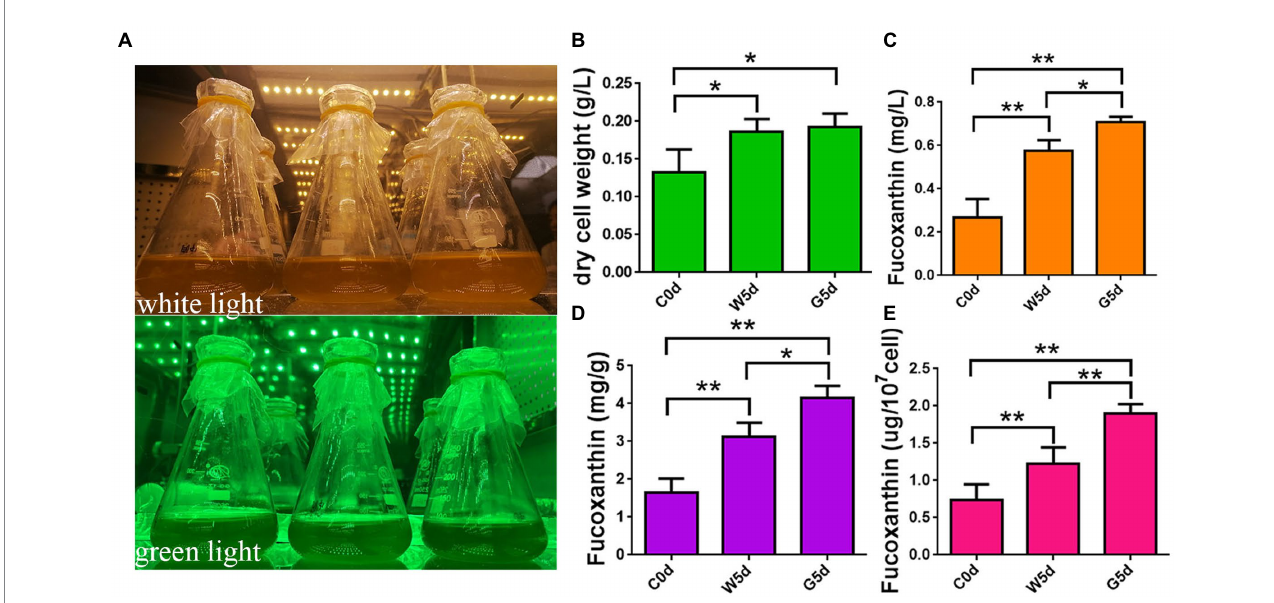
FIGURE 1 Determination of fucoxanthin content by HPLC. (A) Spectrum adjustable plant growth box. (B) Content of dry cell weight. (C) Content of fucoxanthin in culture system. (D) Content of fucoxanthin in unit dry weight. (E) Content of fucoxanthin in unit cell. C0d: Isochrysis galbana cultured under green light irradiation 100 μ mol photons m − 2 s − 1 or white light of 100 μ mol photons m − 2 s − 1 for 0 days. W5d: I. galbana cultured under white light of 100 μ mol photons m − 2 s − 1 for 5 days. G5d: I. galbana cultured under green light of 100 μ mol photons m − 2 s − 1 for 5 days. All experiments were performed in triplicate. Each value presents the mean ± SD. “I” represents error bars for the various determinations ( n = 3). “*” and “**” indicate that significance is at 0.05 and 0.01,